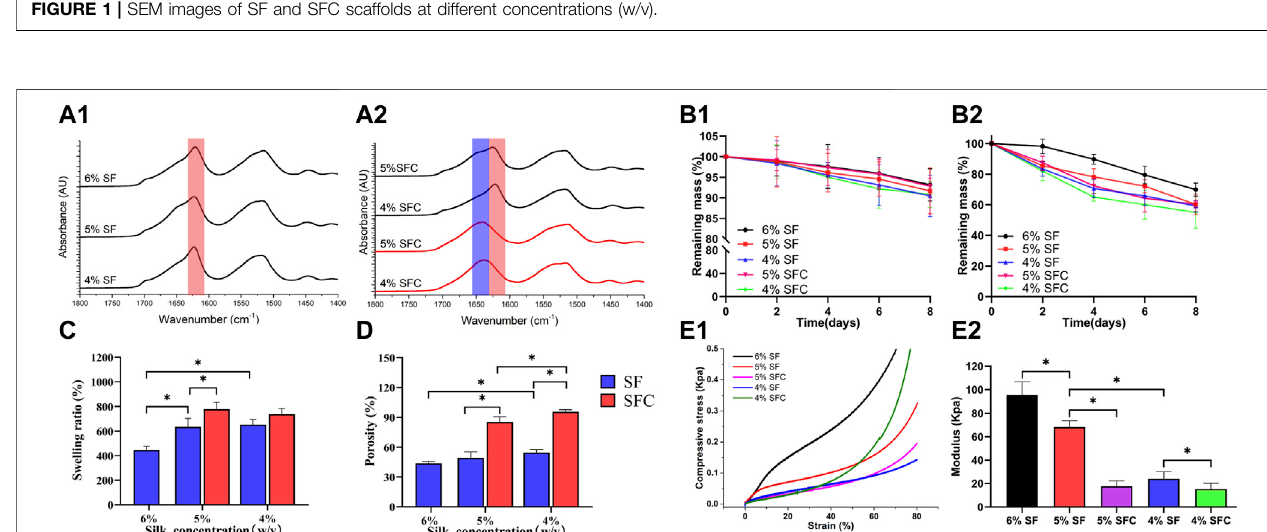
FIGURE 2 | Physical performance of SF and SFC scaffolds at concentrations of 4, 5, and 6% (w/v). FTIR spectra of SF (A1) and SFC (A2) scaffolds at different concentrations (w/v) before (red line) and after (dark line) autoclaving. Time-dependent weight change of SF and SFC scaffolds in a PBS buffer (B1) and protease XIV solution (B2) are shown. Adding collagen I increased the swelling ratio (C) and porosity (D) . A compressive stress – strain curve showing SF and SFC scaffolds in the hydrated state (E1) and the summary of the compressive modulus for SF and SFC scaffolds (E2) . (* p < 0.05).